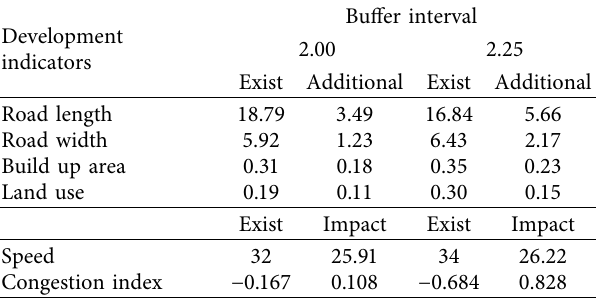
Table 6: Relationship between bufer interval and development indicators.